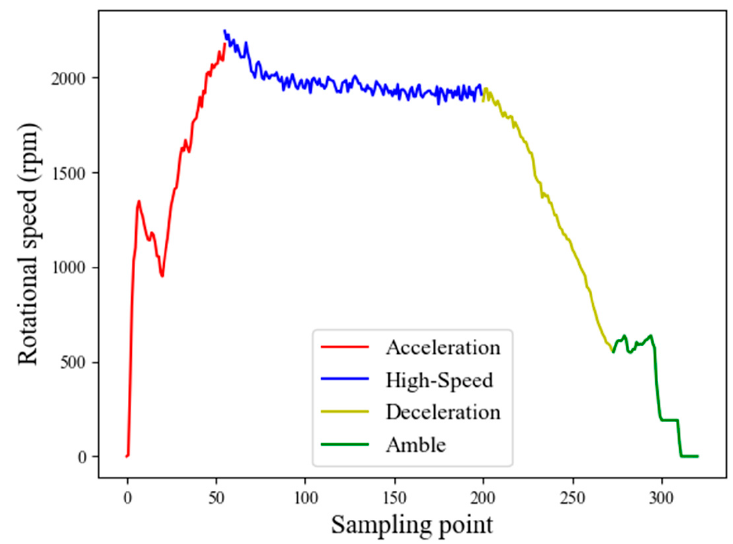
Figure 1. Normal rotational speed-time curve.